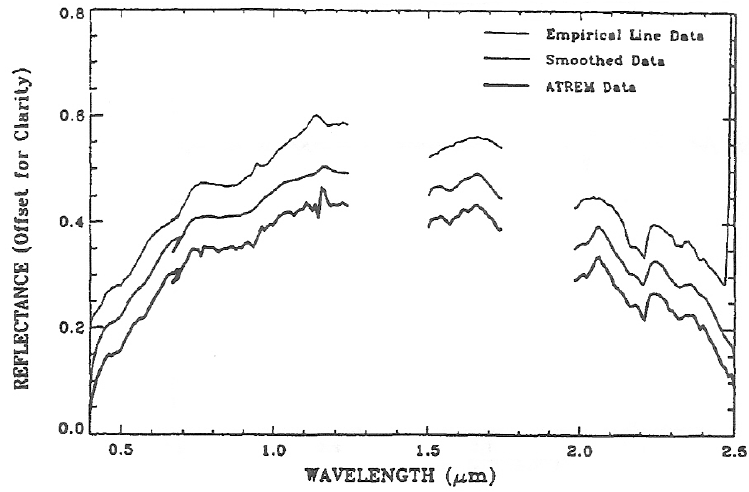
Figure 4. An ATREM reflectance spectrum (lower line), a smoothed spectrum (middle line), and a reflectance spectrum obtained with the empirical line method (upper line). For clarity, the three spectra are vertically